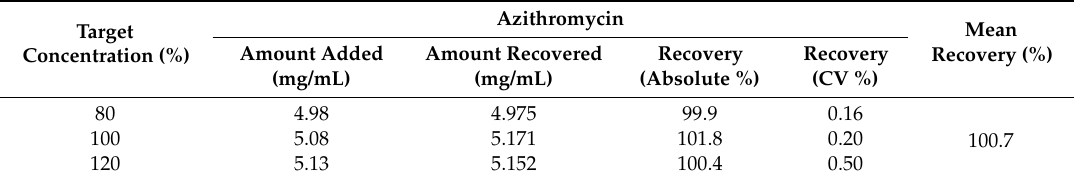
Table 2. Recovery of azithromycin from spiked samples. CV; coefficient of variation.